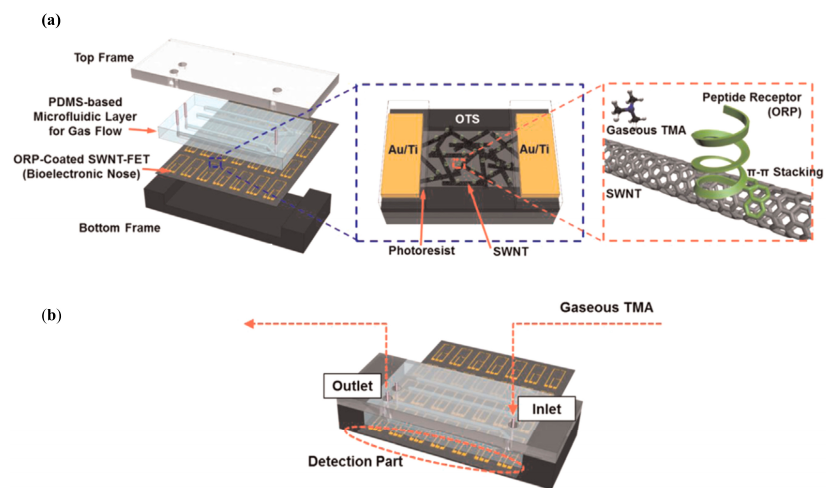
Figure 6. Schematic of the different parts that make up the device. ( a ) The surface of the SWNTs was functionalized with ORPs through π - π stacking. ( b ) The assembled to device for TMA sensing. To facilitate the electrical measurements, the electrodes were exposed to the outside of the platform, creating a detection part. Reproduced with permission from [38] Copyright 2015, Elsevier.